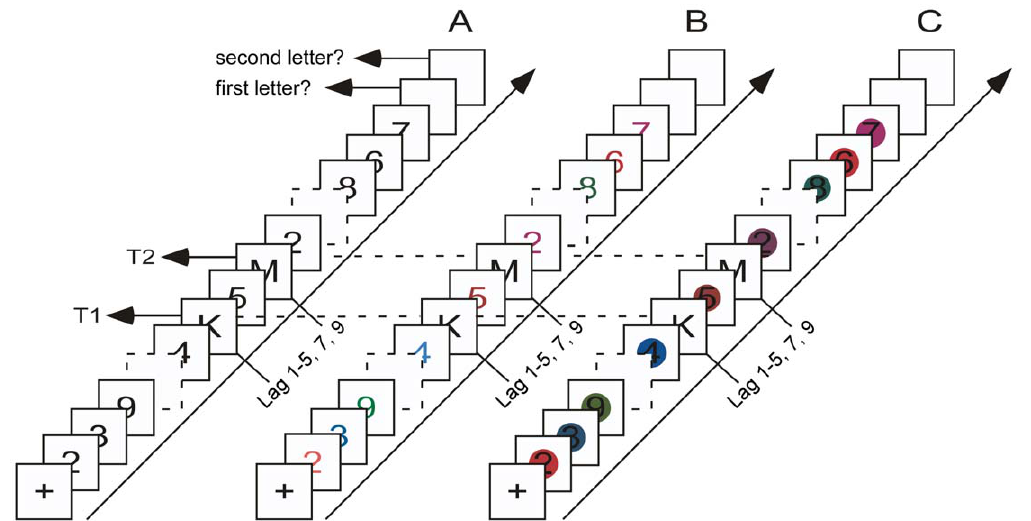
Figure 1. Schematic illustration of the procedures. A) This alphanumeric AB task was used in the control conditions of two experiments, B) this AB task was used in colored digits experimental condition of Experiment 1, C) this AB task was used in black digits in colored circles experimental condition of Experiment 1.